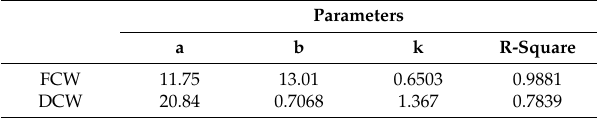
Table 1. Fitting of growth function parameters for S. pohuashanensis suspension cell.